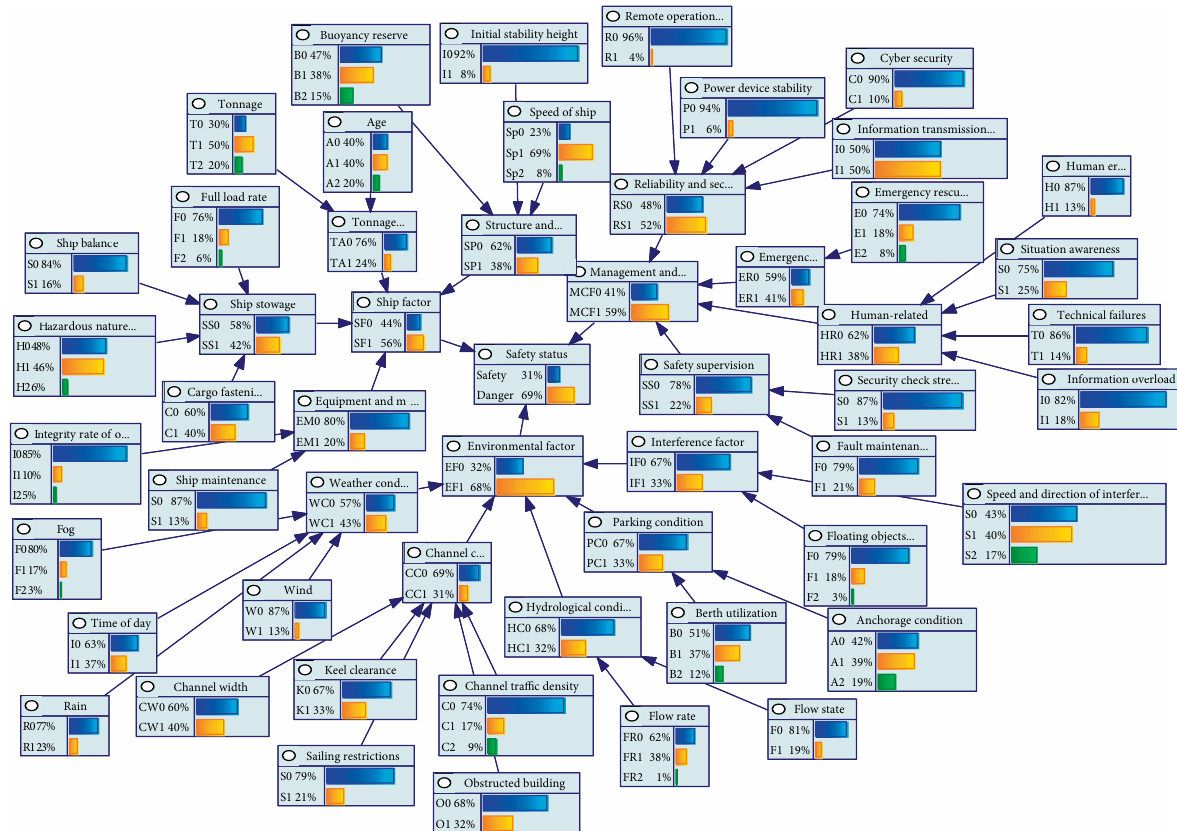
Figure 4: Distribution probabilities for primary causes of shipping safety of inland river unmanned